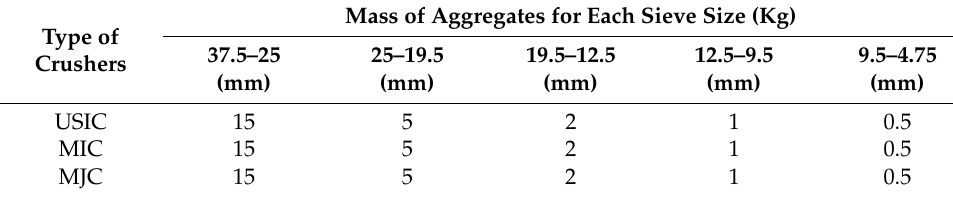
Table 1. Mass of aggregates for different fractions.